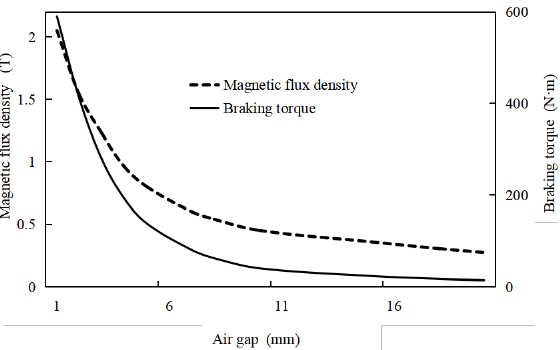
Figure 3. Relation curves of the air gap with magnetic flux density and braking torque.